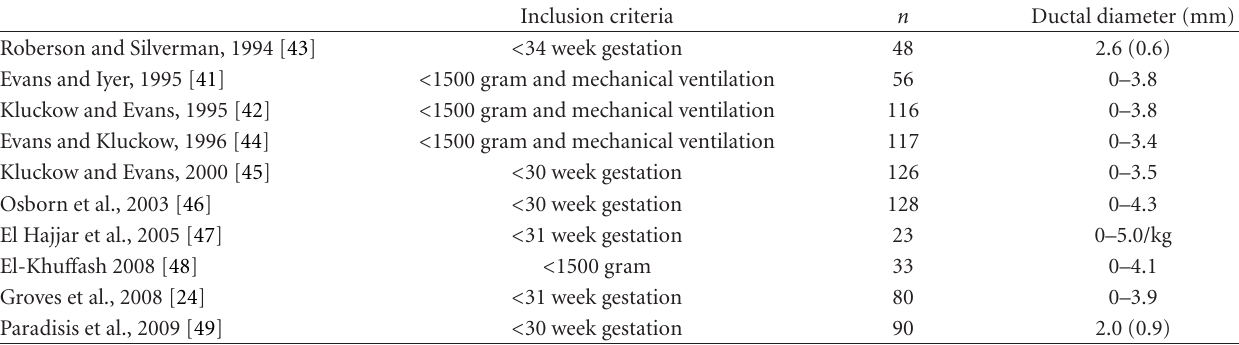
Table 4: Range or mean (SD) of ductal diameters in preterm infants using a high left parasternal view with colour flow mapping at the site of maximum